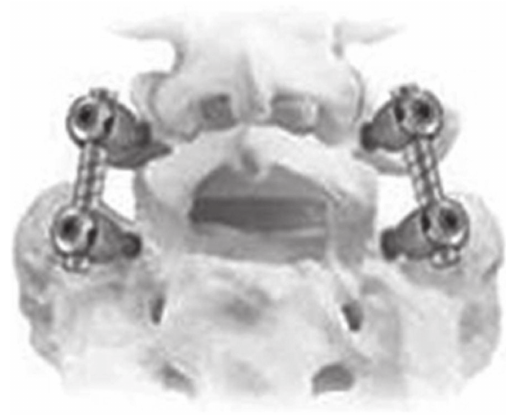
Figure 4: The Accuflex rod system.